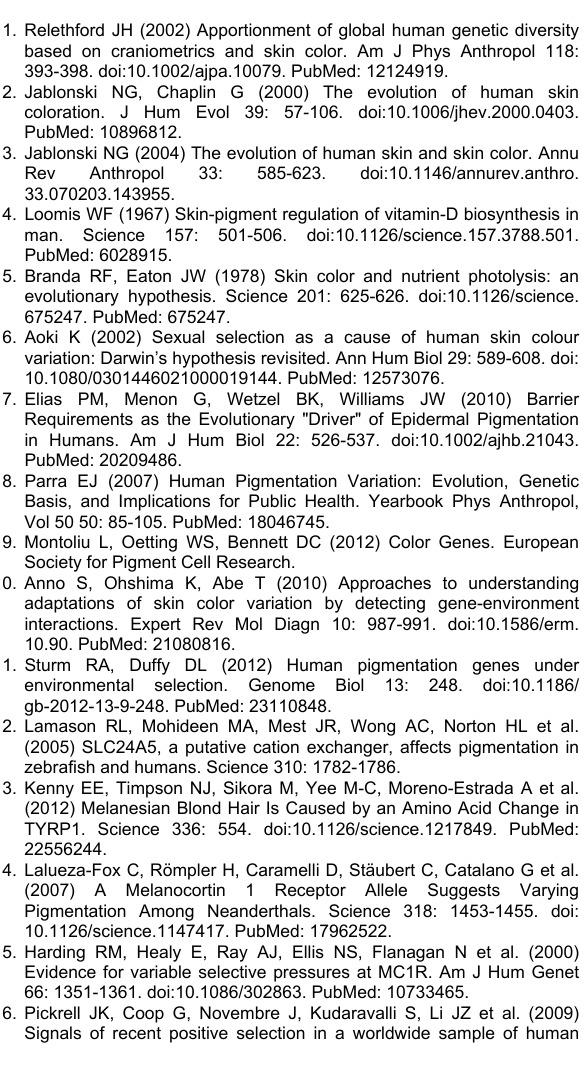
Table S5. Within population differentiation F values ST estimated by AMOVA analysis. Negative F values suggest ST that the true F measures are probably not significantly ST different from 0 and indicate a limited role of the TYR gene in the genetic differentiation within studied (sub-) continental groups.